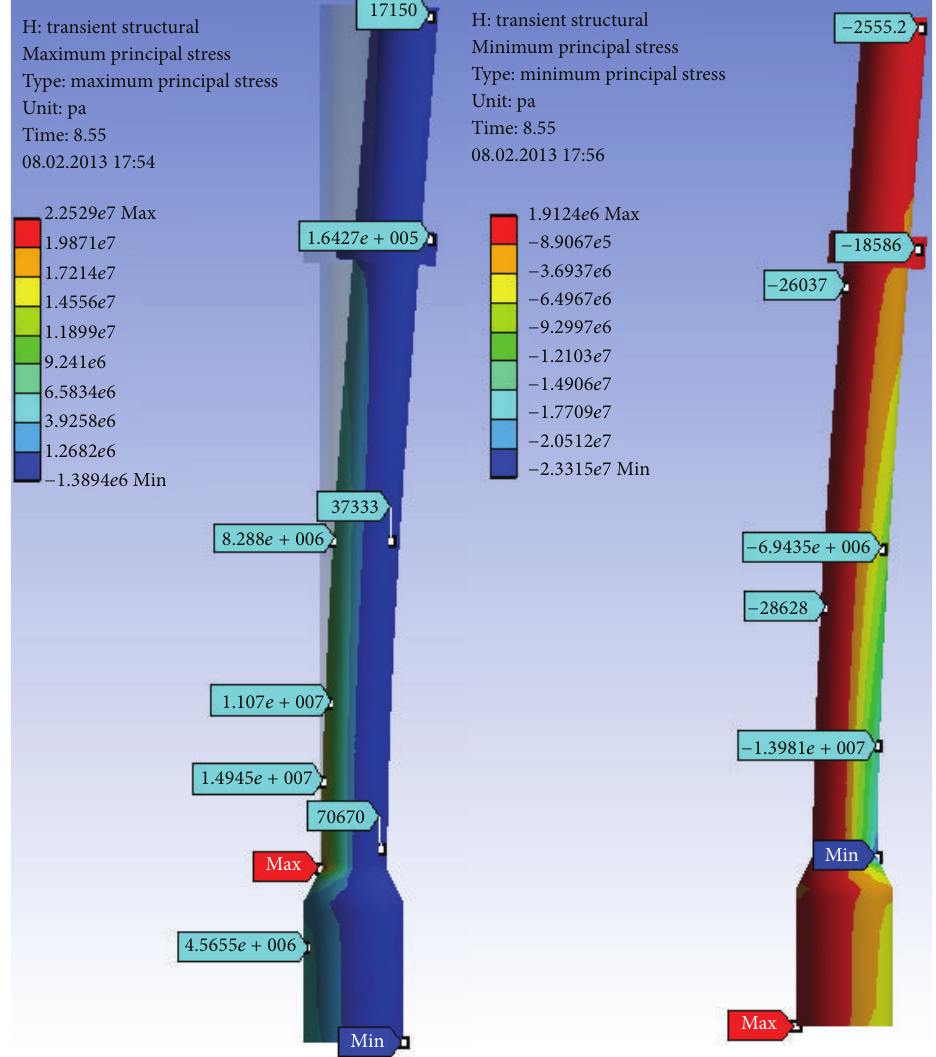
Figure 13: Maximum and minimum principal stress distribution for bare minaret model under the effect of scaled synthetic accelerogram (in